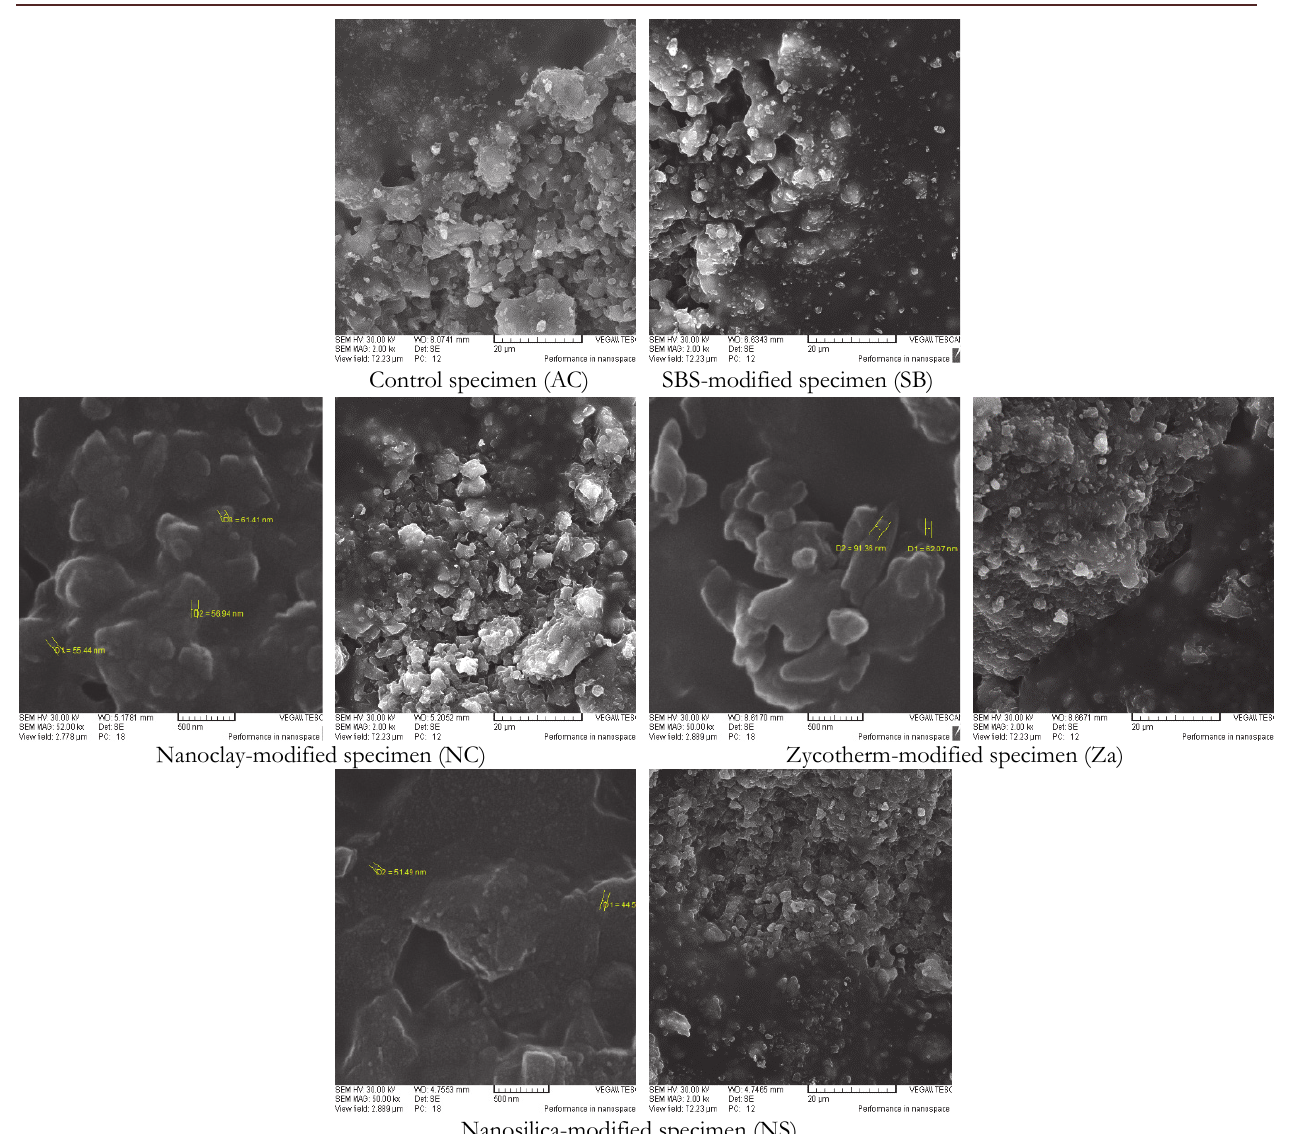
Figure 7: Results of SEM test for modified and non-modified specimens (Samples containing nanoparticles have also been taken for further zooming).